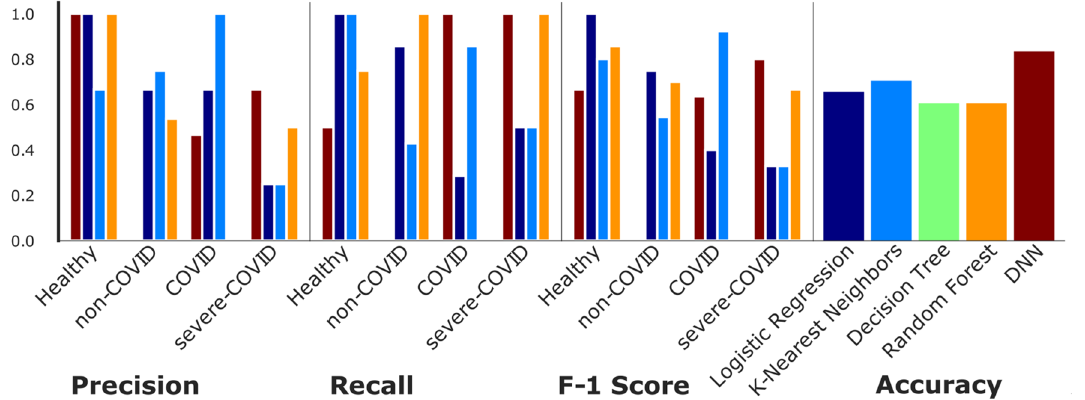
Figure 6. Precision, Recall, and F-1 Score for various ML techniques used for the various groups. The precision of DNN outperforms other methods since it can detect severe-COVID-19 better than the rest of the